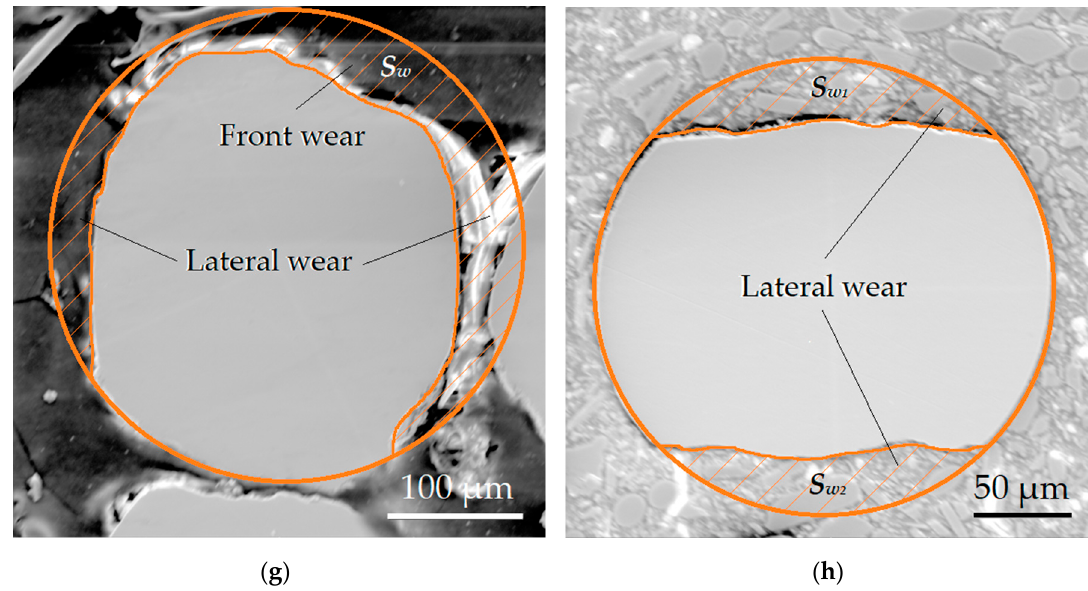
Figure 11. SEM-images of wire tool electrode sample: ( a ) conjugation of front and lateral wear at roughing of 12Kh18N10T (AISI 321) steel, 916×; ( b ) lateral wear at finishing of 12Kh18N10T (AISI 321) steel, 909×; ( c ) conjugation of lateral wear and blank surface at roughing of 12Kh18N10T (AISI 321) steel, 780×; ( d ) front wear at roughing of D16 (AA2024) duralumin, 909×; ( e ) conjugation of front and lateral wear at roughing of D16 (AA2024) duralumin, 1.61k×; ( f ) lateral wear at finishing of D16 (AA2024) duralumin, 2.04k×; ( g ) cross-section after steel roughing, 696×; ( h ) cross-section after steel finishing, 1.02k×. Table 6. Volumetric wear rate of electrical discharge machining of 12Kh18N10T (AISI 321) steel. Type of Machining